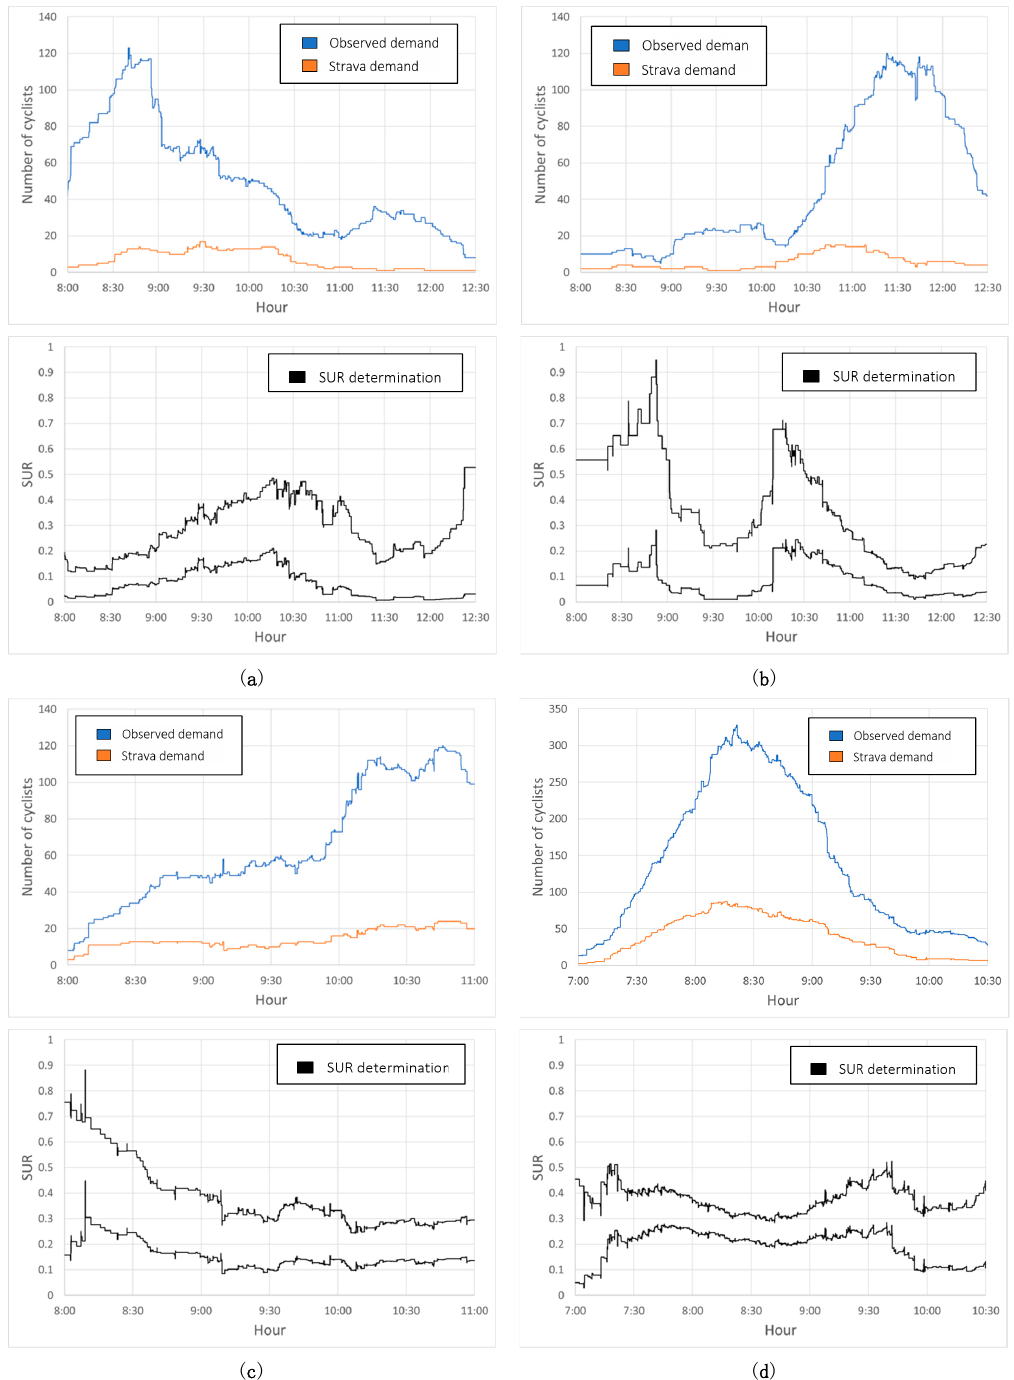
Figure 6. Cycling demand (blue line = observed demand; orange line = Strava demand) and SUR determination: ( a ) OP1, E1: observation code 1.5; ( b ) OP1, S1: observation code 1.5; ( c ) OP2, S1: observation code 2.4; ( d ) OP3, S2: observation code 3.4.